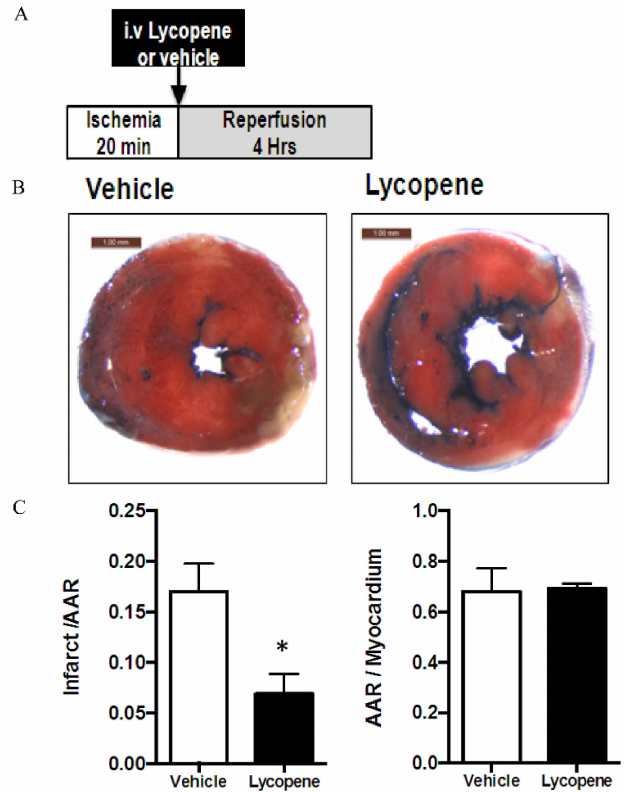
Figure 3. Lycopene (Lyc) reduces myocardial infarct size after ischemia-reperfusion (I/R). In vivo hearts were subjected to 20 min of ischemia followed by 4 h of reperfusion. Four microliters of 15.6 µ M lycopene (in 0.1% DMSO saline solution, v / v ) or vehicle per gram bodyweight was administrated via tail vein injection after 20 min of LAD ligation. The extent of myocardial necrosis was assessed by TTC staining. ( A ) A scheme showing experiment design; ( B ) representative sections of the extent of myocardial infarction; and ( C ) ratio of the infarct size to the area at risk (AAR) ( left ) and the ratio of AAR to the total myocardial area ( right ). Values are means ˘ SEM of ě 4 in each group, * p < 0.01 vs.